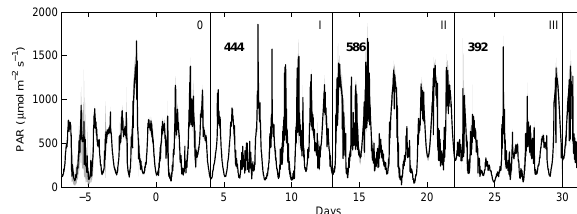
Fig. 4. Changes in photosynthetic active radiation (PAR) at ground level with time as measured by two LICOR sensors. The black line denotes the mean of both measurements while the grey shaded area illustrates the variability between them. Numbers denote average PAR levels during a certain phase, indicated by Roman numbers.